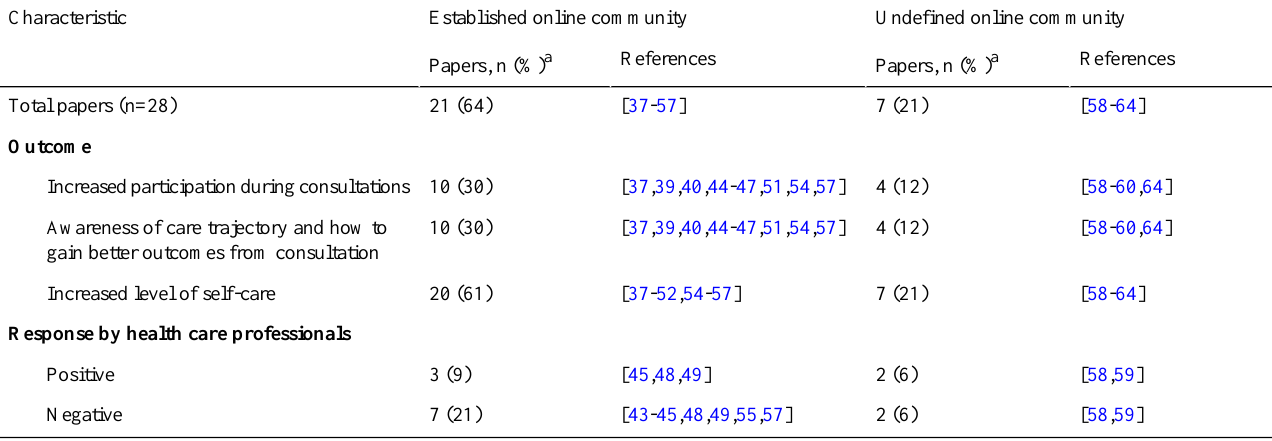
Table 4. The outcome of patient involvement and participation in established and undefined communities.